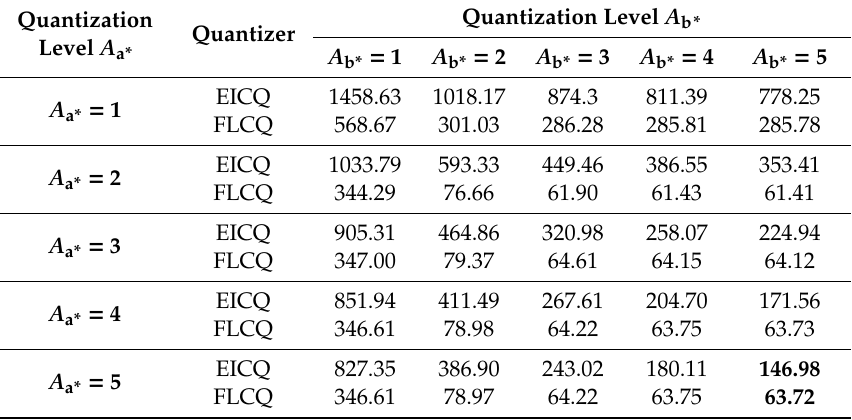
Table A3. The mean square error of the EICQ and FLCQ quantizers on ZuBuD.